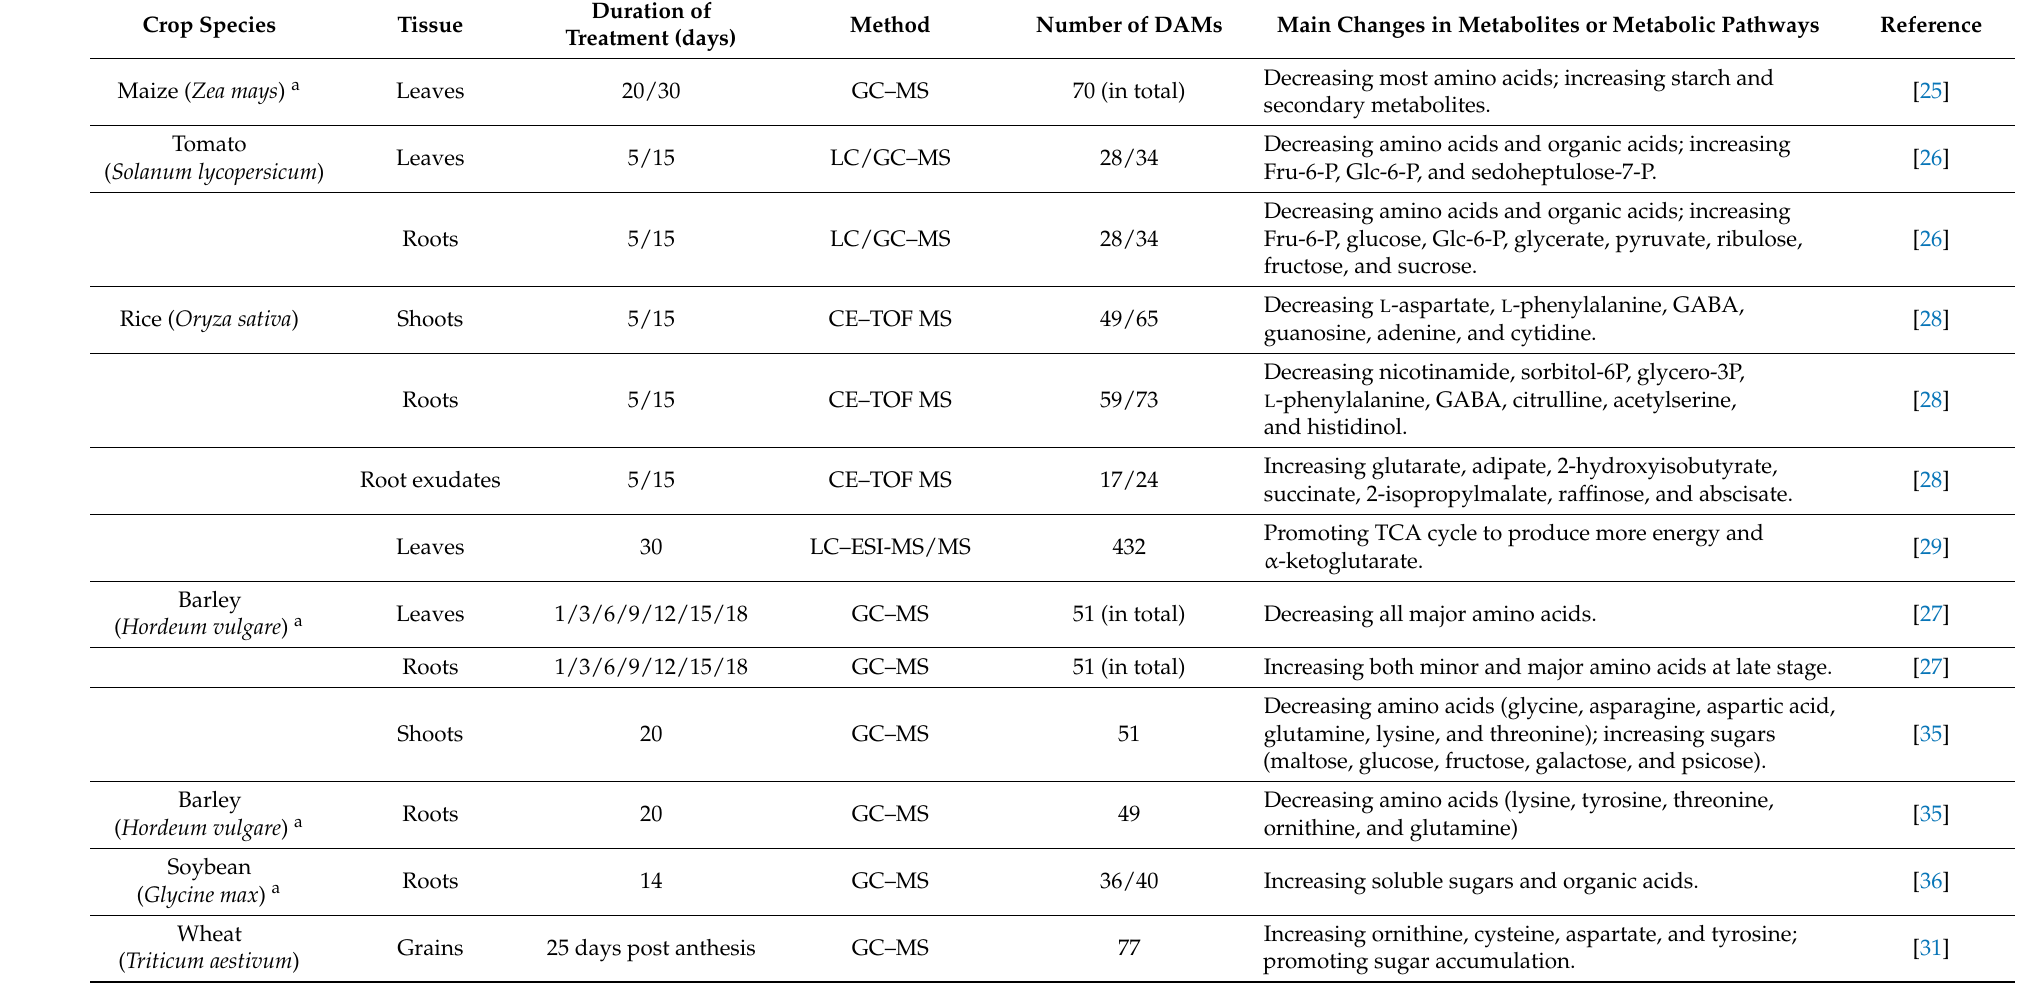
Table 1. Metabolome analyses of crop responses to N